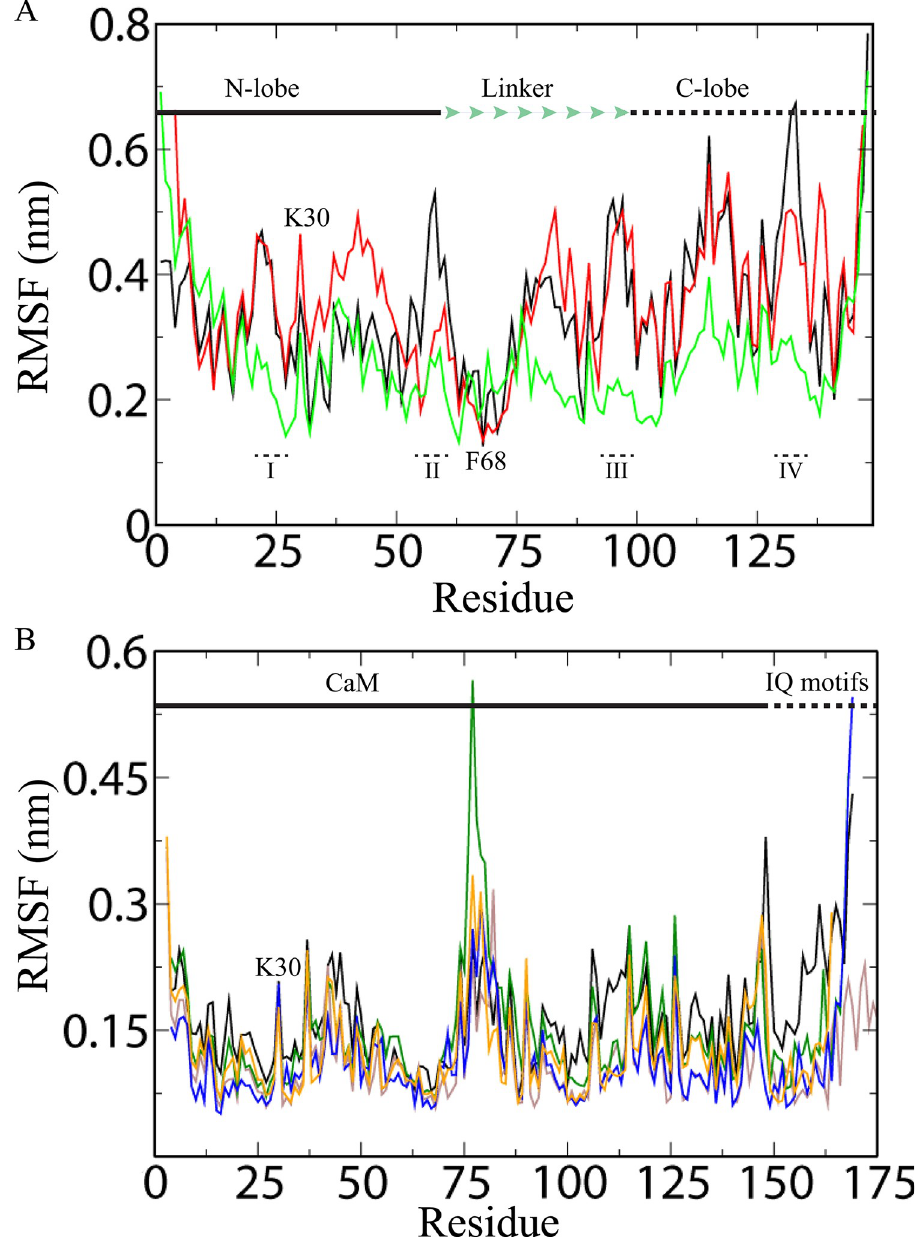
Fig 3. Root-mean-square fluctuations (RMSF) of CaM complexes. (A) apo CaM (black), extended Ca 2+ /CaM (red), and compact Ca 2+ /CaM (green); (B) Ca 2+ /CaM-Cav1.1IQ (black), Ca 2+ /CaM-Cav1.2IQ (brown), Ca 2+ /CaM-Cav2.1IQ (green), Ca 2+ /CaM-Cav2.2IQ (blue), and Ca 2+ /CaM-Cav2.3IQ (orange). The N- and C-lobes, linker, and IQ motifs are marked. EF hand loops I (D20-T28), loops II (D56-P66), loops III (D93-Y99), and loops IV (I130-E140) are also